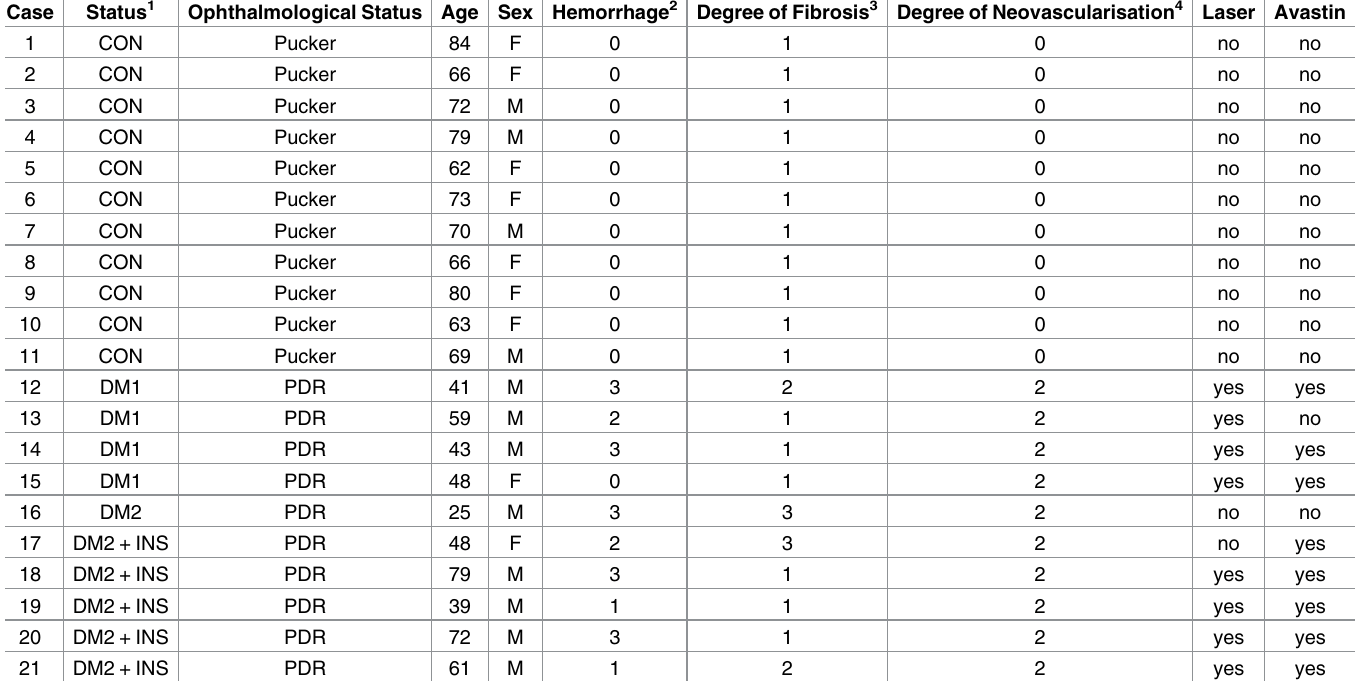
Table 2. Clinical characteristics of patients whose fibrovascular membraneswhere used for mRNA